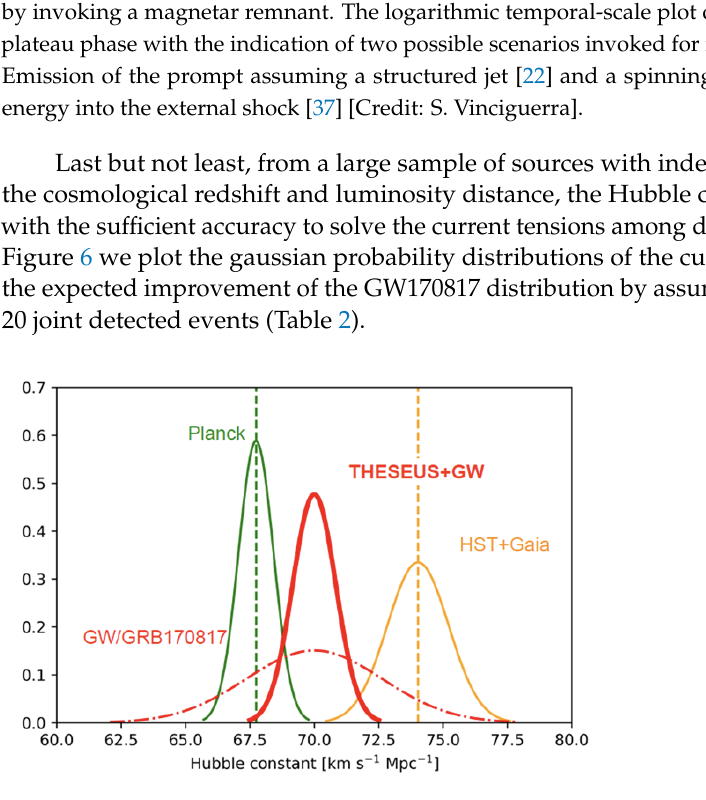
Figure 6. Gaussian probability distribution of the current H 0 measurements, including the one obtained from the BNS GW170817, and the expected one with ∼ 20 joint GW+GRB detections. During the end of the 2030s, 20 joint detection is a conservative estimate for three years of synergies between THESEUS and a network of ET and 2 CE by taking into account the expected fraction of short GRB for which a redshift can be